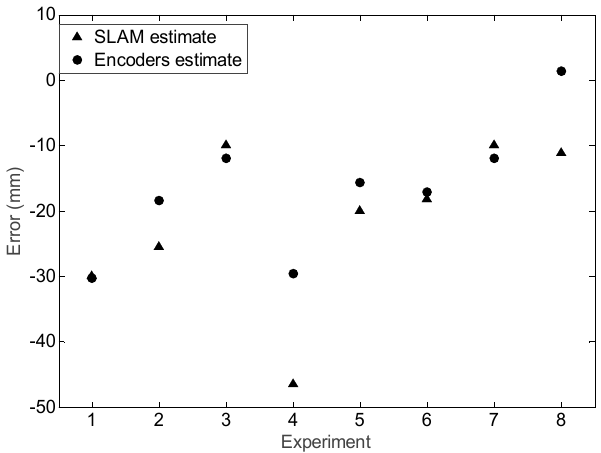
Figure 26. Absolute displacement error obtained when comparing the planned displacement and the final displacement estimated with the SLAM procedure and with the encoders and the kinematic model.